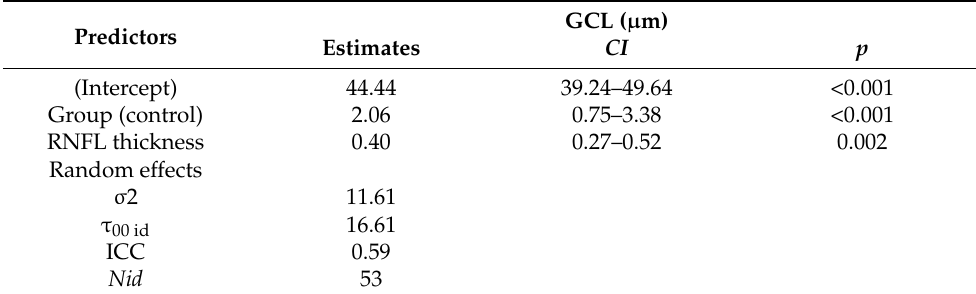
Table 2. Results of fitting model 2.